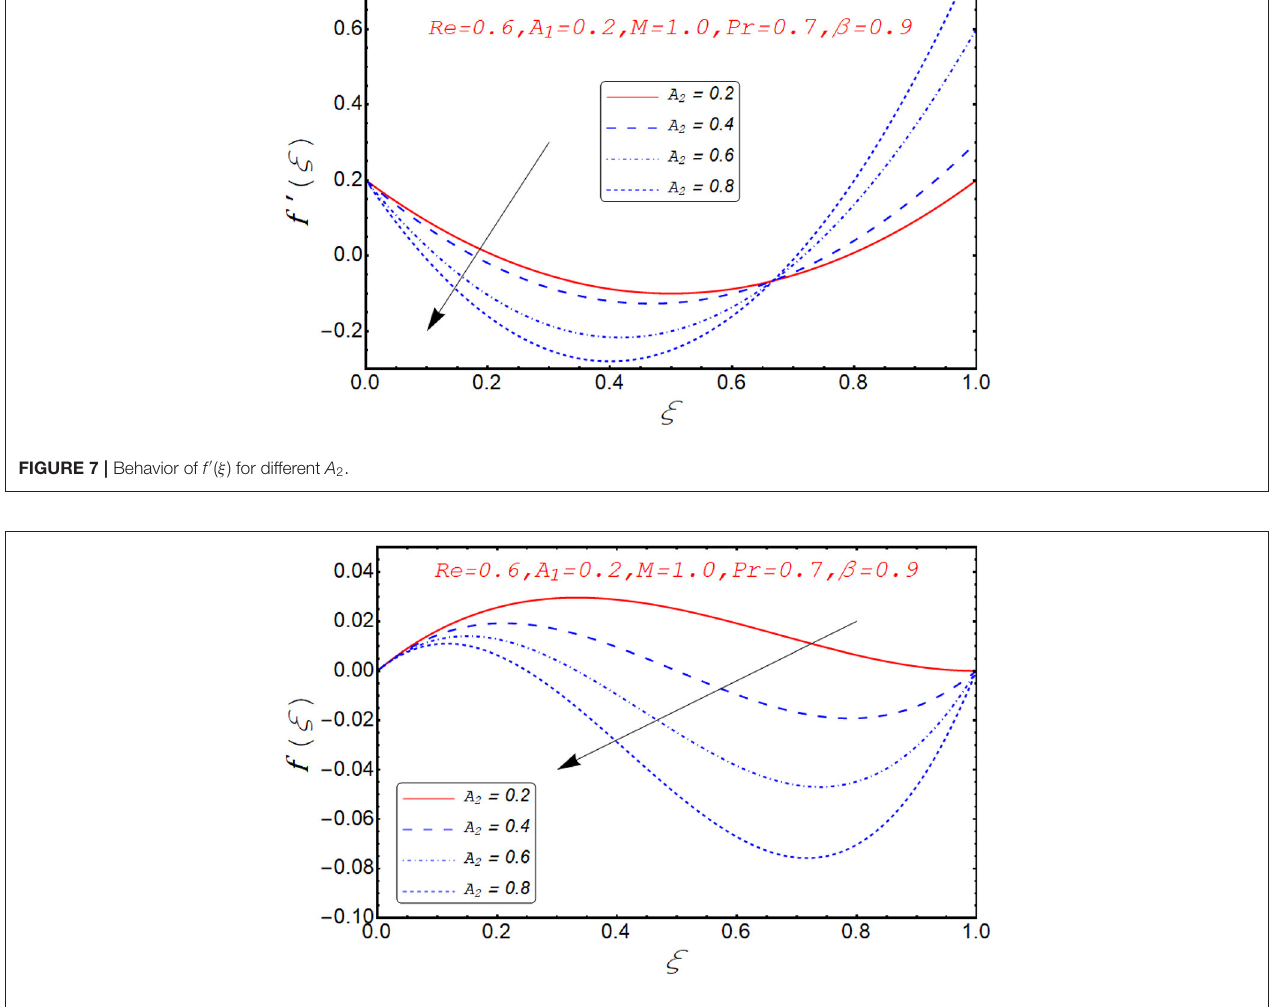
FIGURE 8 | Behavior of f ( ξ ) for different A 2